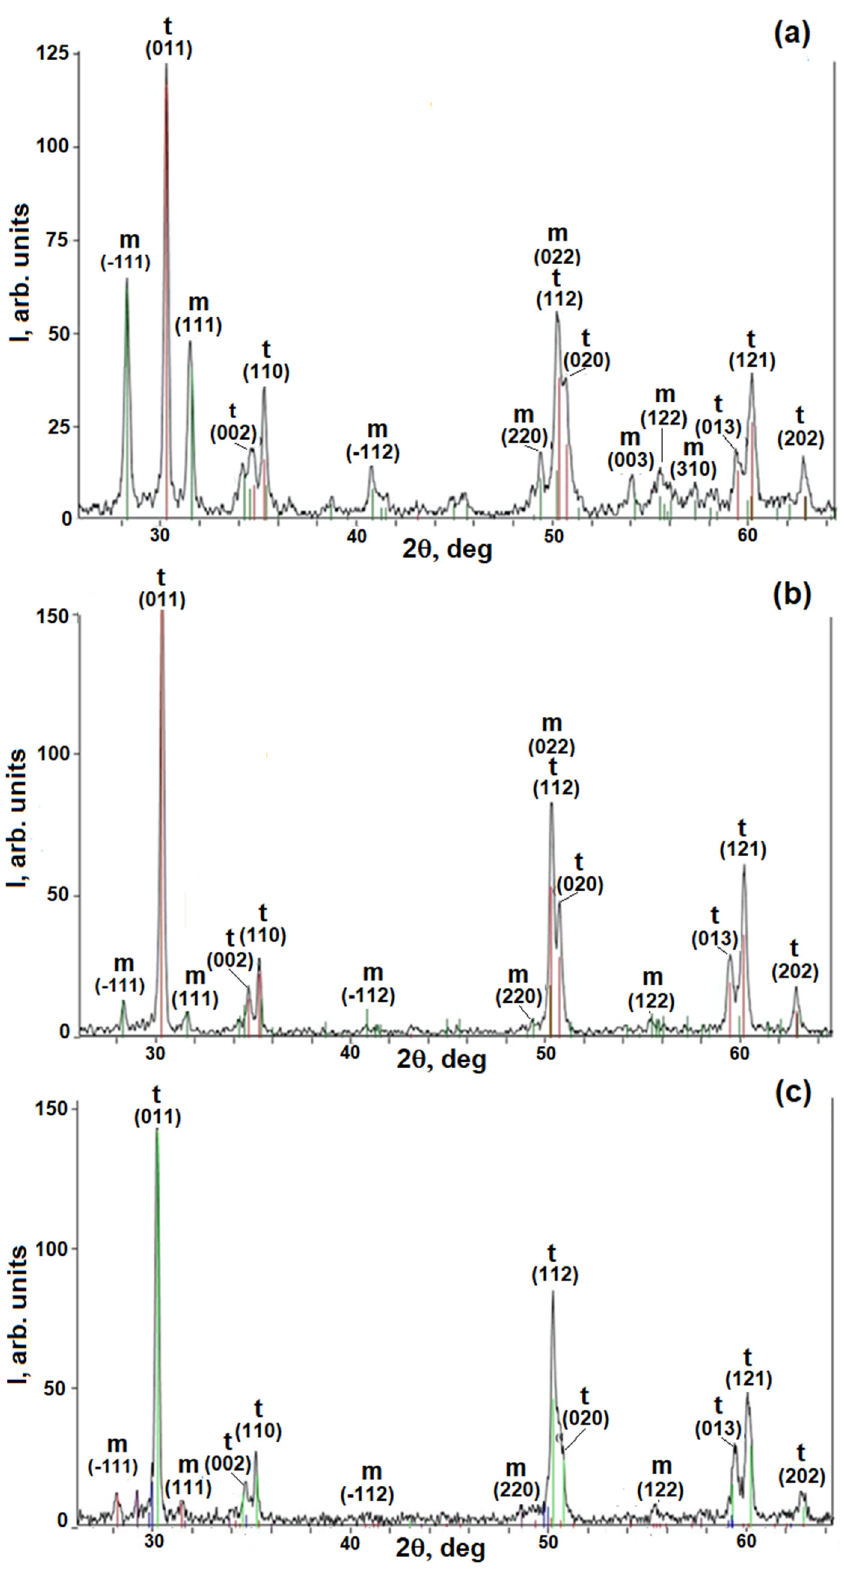
Figure 7. X-ray diffraction patterns of PEO coatings formed at current densities 20 ( a ), 30 ( b ), and 40 ( c ) A/dm 2 . m—monoclinic phase of ZrO 2 ; t—tetragonal phase of ZrO 2 .